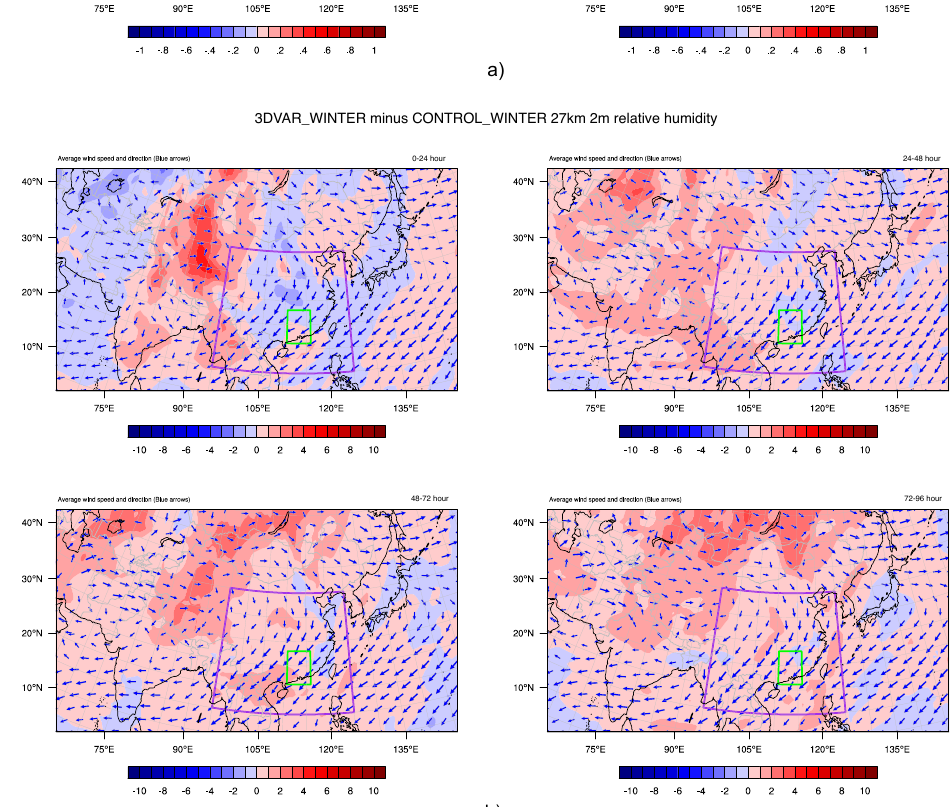
Figure 5.6: The contour plots show the di ↵ erence of the (a) 2m temperature and (b) 2m relative humidity at four di ↵ erent time periods, (1) 0-24 hours, (2) 24-48 hours, (3) 48-72 hours, and (4) 72-96 hours, between the 3DVAR WINTER and the CONTROL WINTER in the 27km domain. The blue arrows indicate the monthly averaged wind speed and direction to show the general wind pattern of this season. The purple box is where the observations for evaluating the 27km domain are located and the green box is the 3km domain.